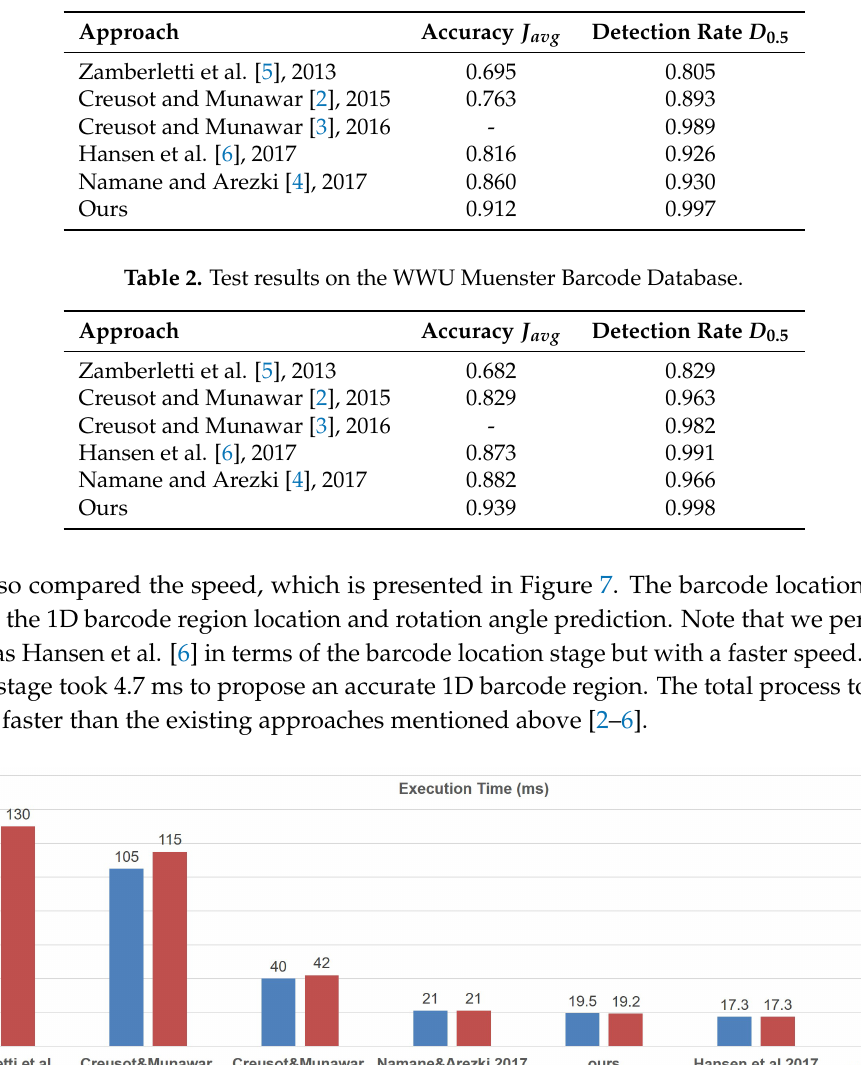
Table 1. Test results on the ArteLab Rotated Barcode Dataset.